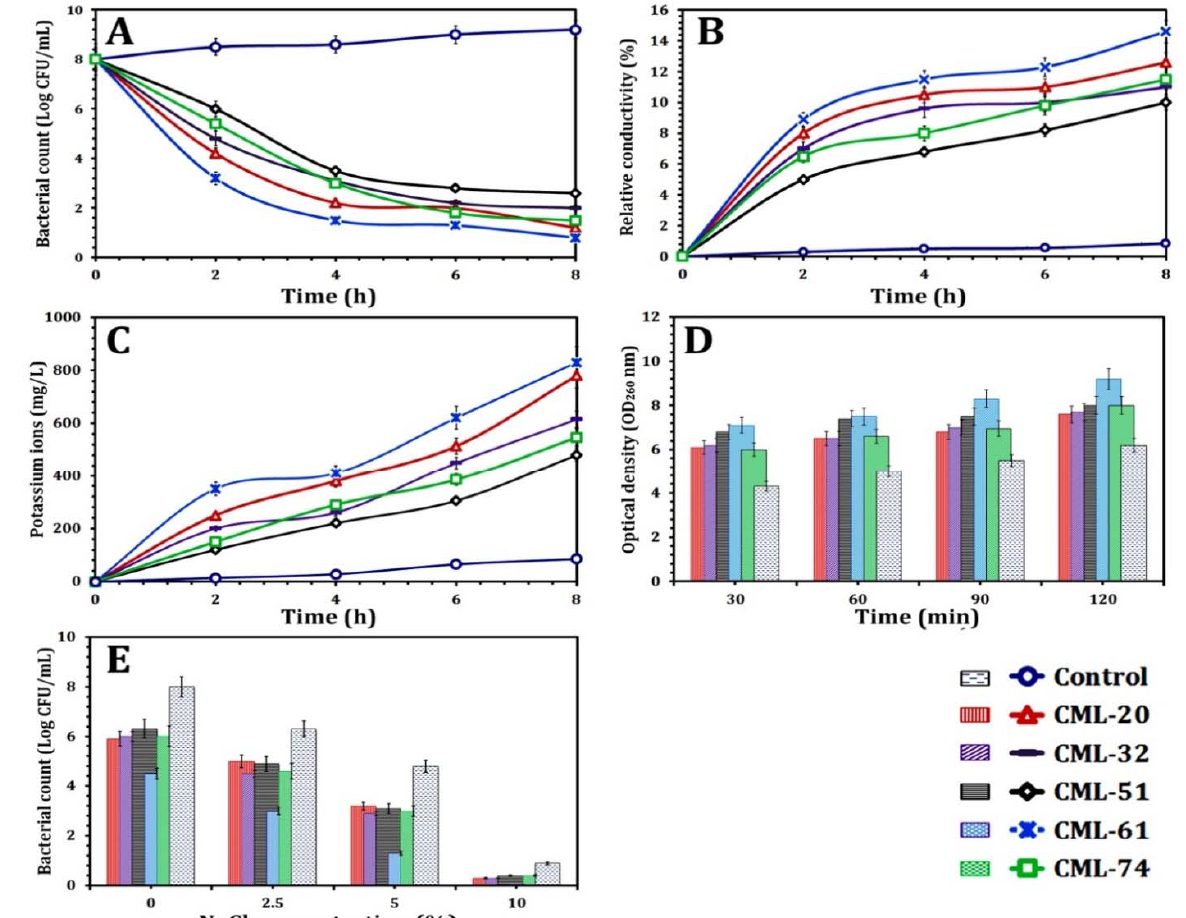
Figure 5. The antilisterial mechanism assays of cinnamon essential oil: ( A ) time–kill assay, ( B ) permeability of cell membrane, ( C ) leakage of potassium ions, ( D ) cell membrane integrity, and ( E ) loss of salt tolerance capacity.